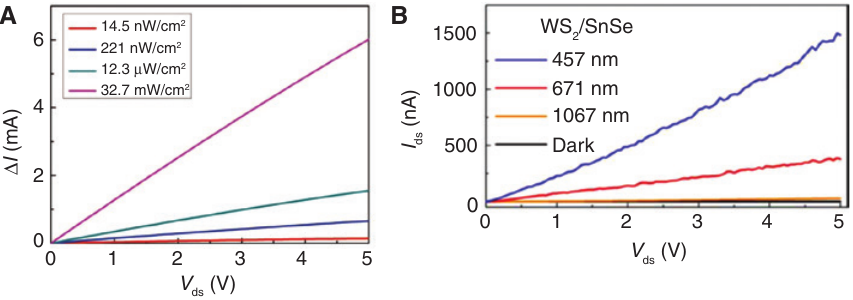
Figure 5: Photocurrent as a function of the drain-source voltage at various EM powers: (A) the graphene transistor with PbS QDs [10] and (B) the WS transistor with PbS QDs 2